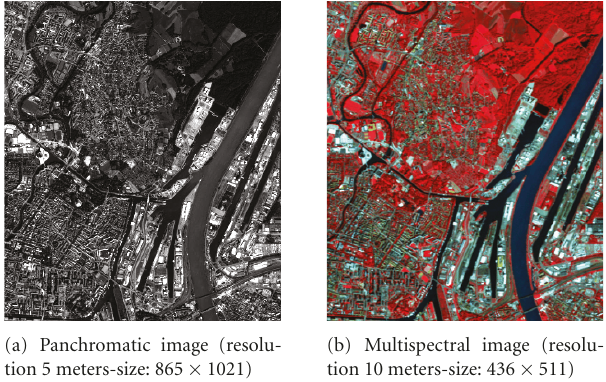
Figure 8: The two images of Strasbourg (France) from